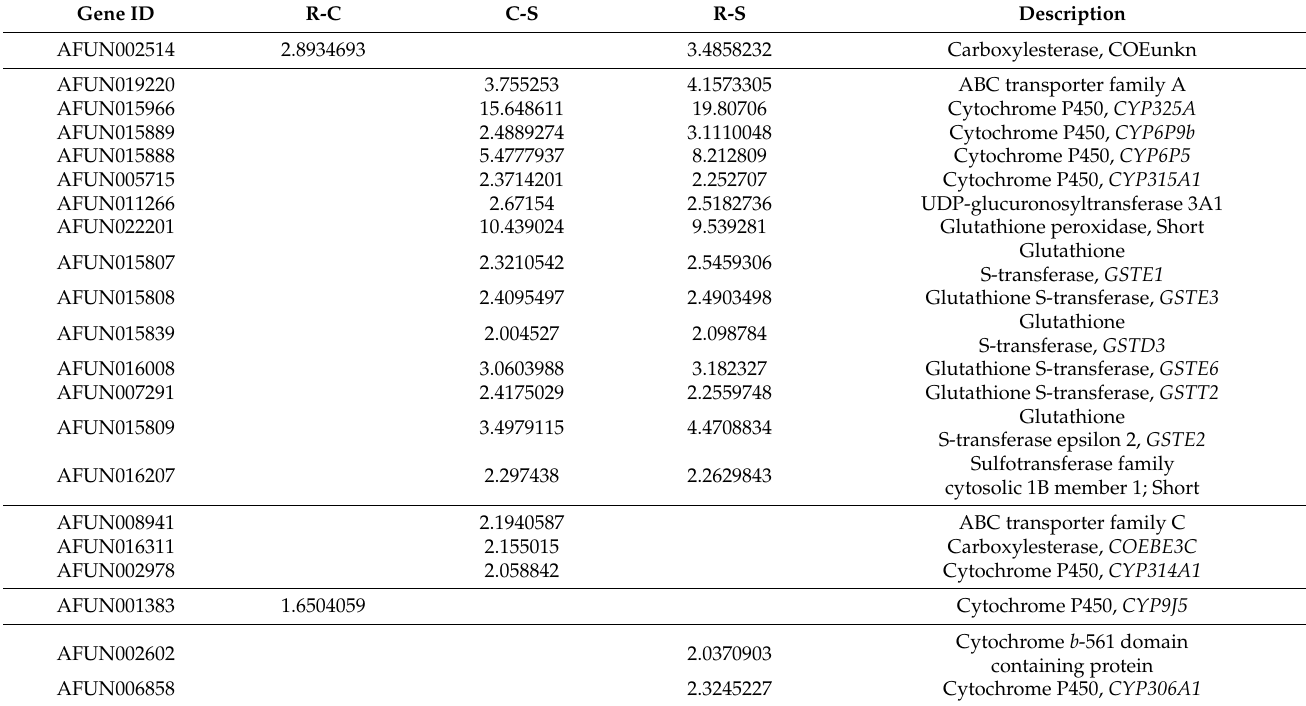
Table 1. Detoxification genes differentially expressed in Cameroon An. funestus between different comparisons at false discovery rate (FDR) < 0.05 and fold change (FC) > 1.5 for genes induced upon exposure and constitutive expression (R-C) or FC > 2 for constitutive differential expression (C-S) and genes induced upon exposure and constitutive expression